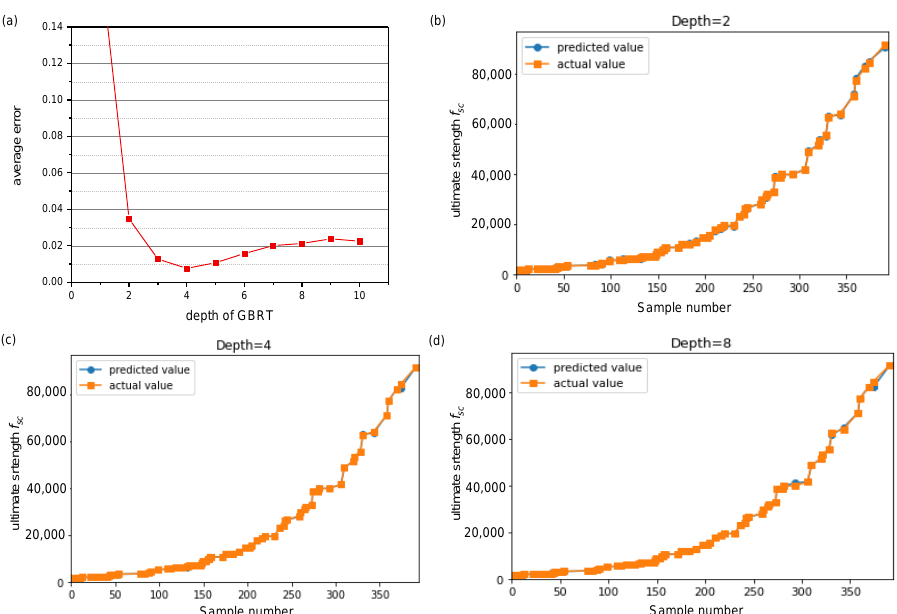
Figure 6. The prediction errors for the different tree depth ( a ) and the prediction results of the tree depths of 2, 4 and 8 respectively ( b – d ).